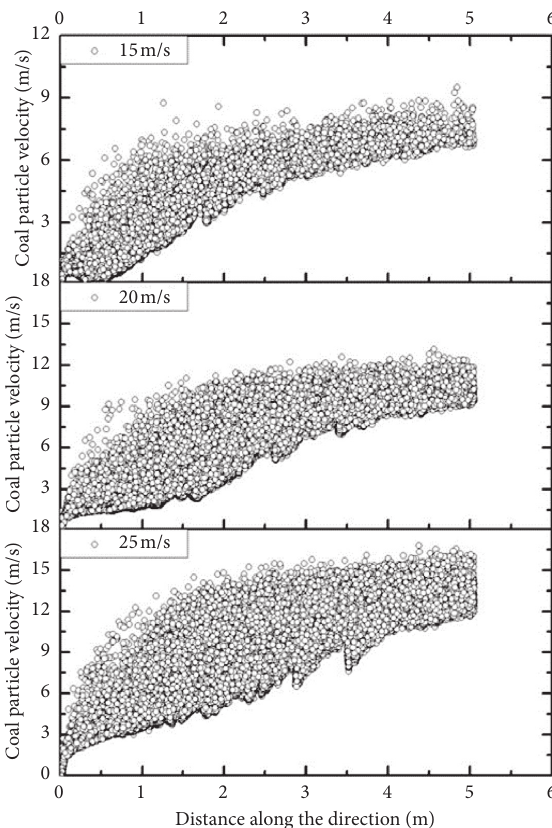
Figure 13: Coal particle velocity distribution along the flow di- rection with particle generation rate of 0.03kg/s ( t � 3.0s).